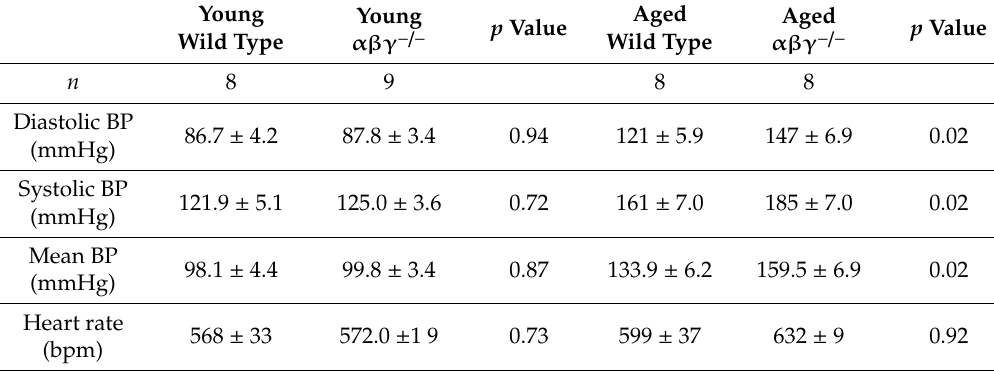
Table 2. Hemodynamic parameters measured using tail-cu ff plethysmograph in conscious αβγ − / − and wild-type control animals for both young and aged groups. Means ± S.E.M were compared with Mann–Whitney U rank